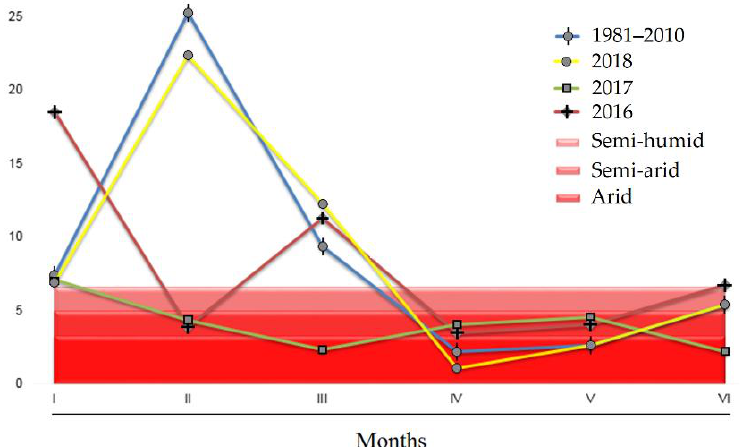
Figure 1. Gračanin’s rain factor (GRF) for growing seasons (2016, 2017, 2018) and refe rent period (1981 –